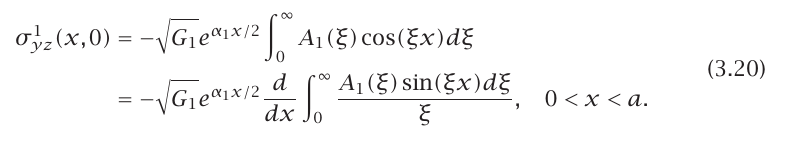
x for different values of 1 with = 0 . 5, and β = 0 . 2